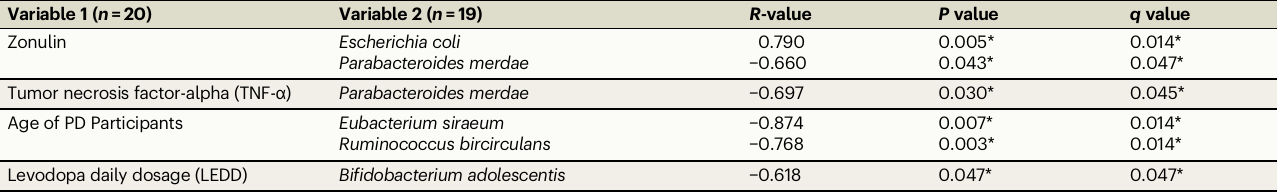
Table 3 | Signi fi cant associations between study outcomes Variable 1 ( n